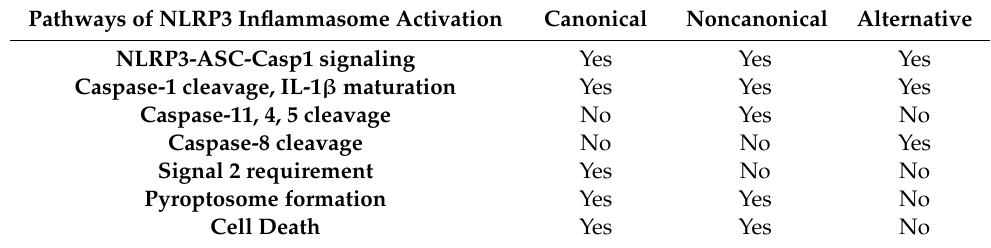
Table 1. Key characteristics of canonical, noncanonical and alternative NLRP3 activation. Pathways of NLRP3 Inflammasome Activation Canonical